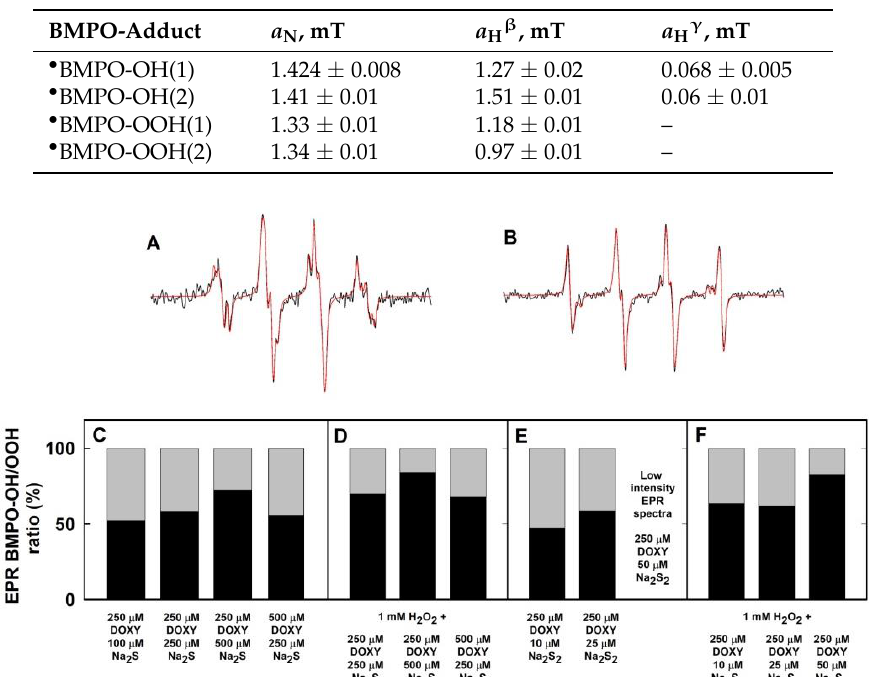
Table 1. Hyperfine coupling constants of the BMPO spin adducts elucidated from the simulations of experimental spectra measured in the buffer solutions. • BMPO-OOH and • BMPO-OH were simulated based on two conformers.